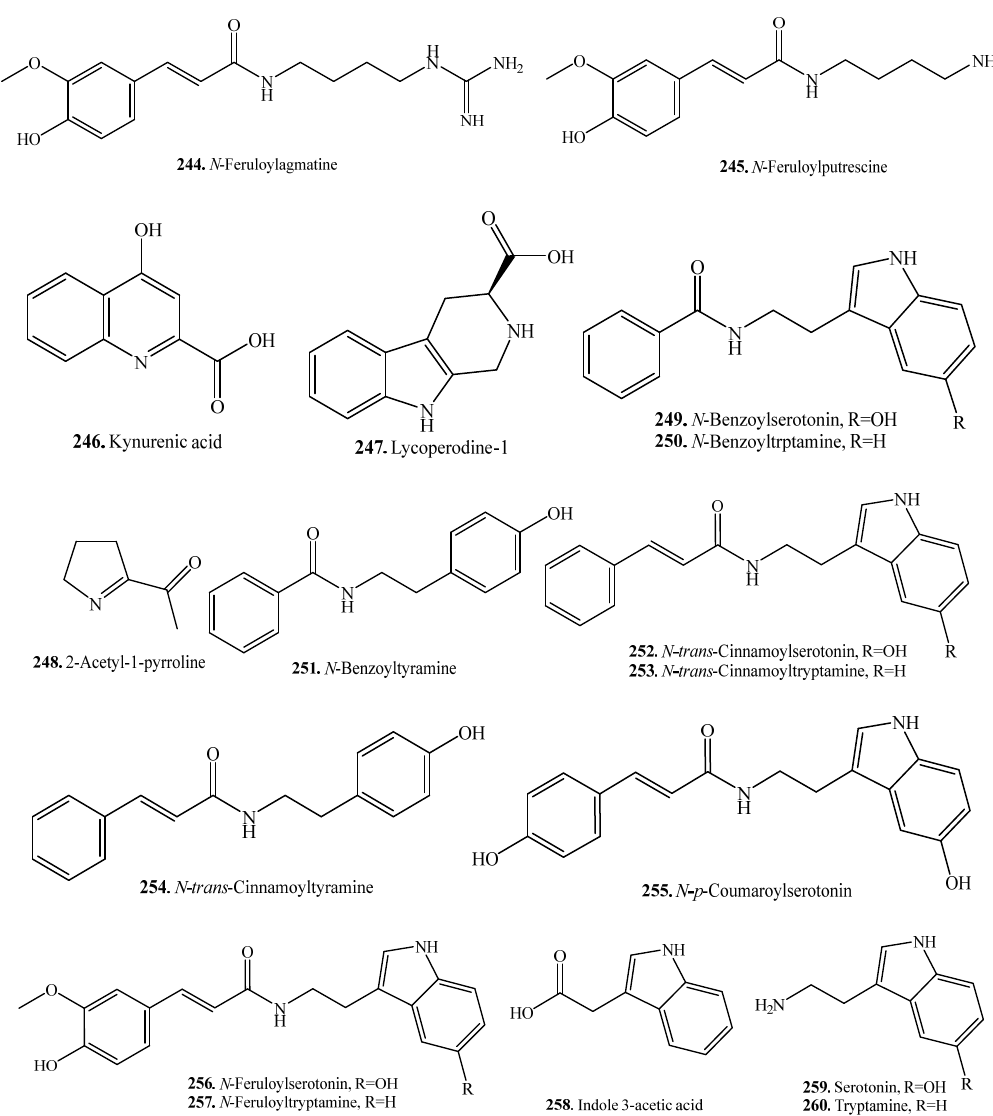
Figure 8. Structures of the alkaloids isolated from